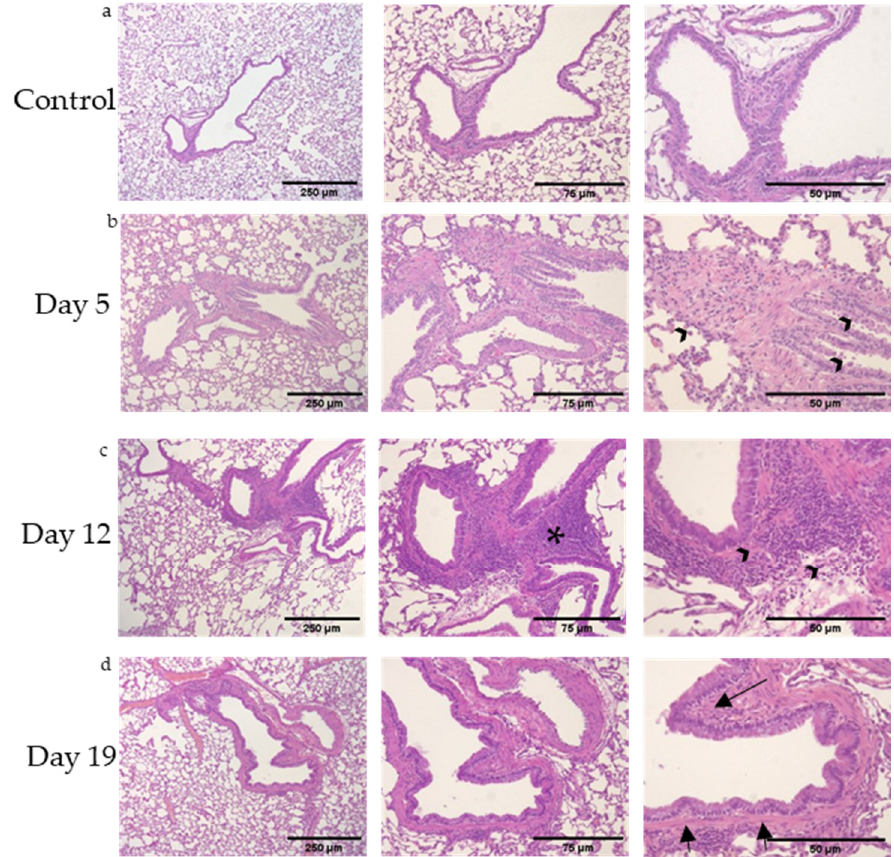
Figure 1. Representative rat lung tissue stained for hematoxylin and eosin (H&E) (bar: 250 µ m (left column), 75 µ m (middle column), and 50 µ m (right column)). ( a ) Room air (control)-exposed